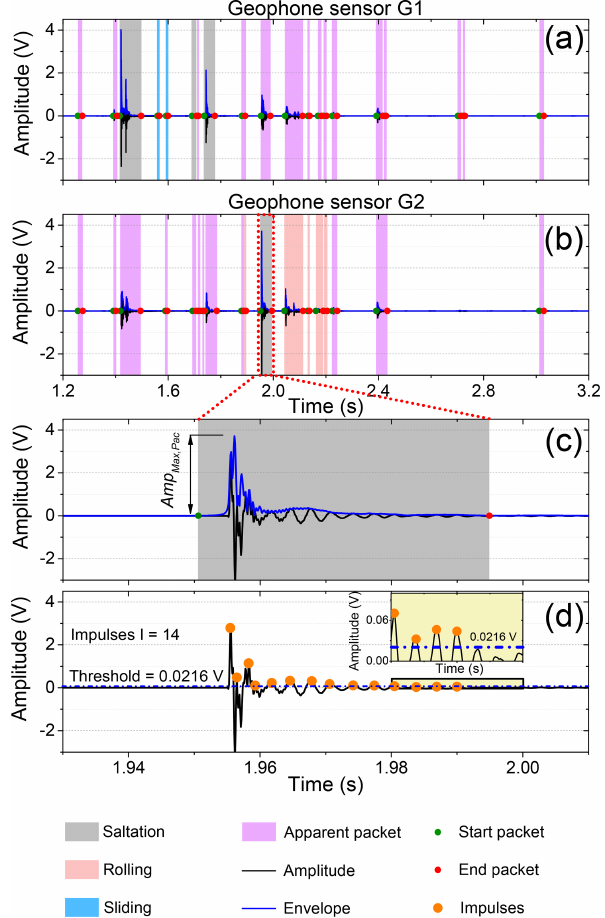
Figure 5. Illustration of the SPG vibrations and signal packets for different transport modes following a flume experiment with bed- load particles of grain-size class C9. Panels (a) and (b) represent signals that were recorded by geophone sensor G1 and G2, respec- tively, with a flow velocity of 3.3ms − 1 . (c) Illustration of the packet definition as the envelope (blue line) of the raw signal that is com- puted with the Hilbert transform and represents one impact of a saltating particle. (d) Definition of the impulse count I ( = 14) as the number of times the signal exceeds the threshold (0.0216V, see the dash-dotted blue line) in the positive